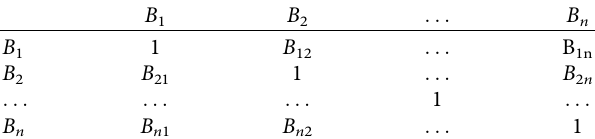
Table 1: Importance judgment